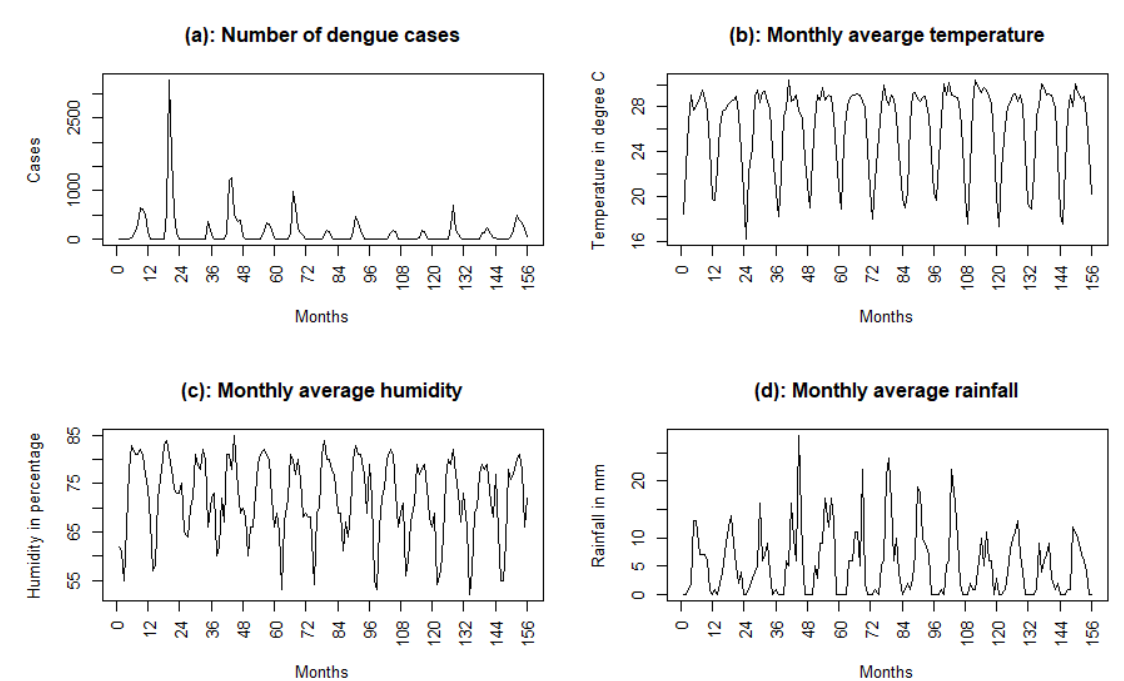
Figure 4. Patterns in the distribution of monthly data for dengue cases and selected climate factors for the 2001–2013 period in the city of Dhaka, Bangladesh: ( a ) number of dengue cases; ( b ) average monthly temperature; ( c ) average monthly relative humidity; ( d ) average monthly rainfall. Note: Every 12 months = 1 year, starting from year 2001 to year 2013. Thus,